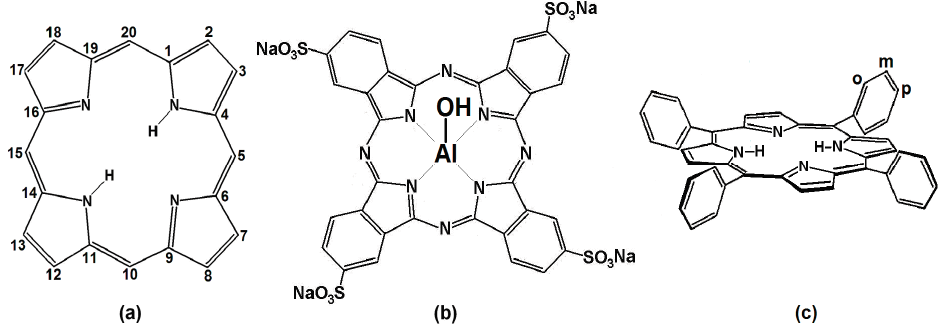
Figure 1. Chemical structures of: ( a ) free bases of porphyrin macrocycles; ( b ) the μ - oxo- tetrasulfophthalocyanine of Aluminum (III), (OH)AlTSPc; ( c ) ortho- , meta- and para -positions in meso -tetraphenylporphyrin (H 2 T( o- , m- , p-S